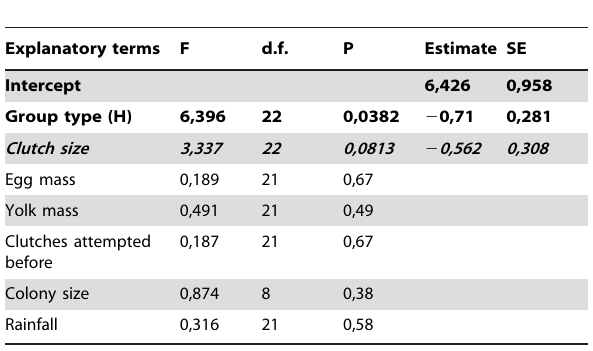
7.31 pg.mg 2 1 and 21.54 pg.mg 2 1 . It did not vary with the for the first eggs of females with helpers than for females in pairs Table 4. Factors affecting yolk testosterone